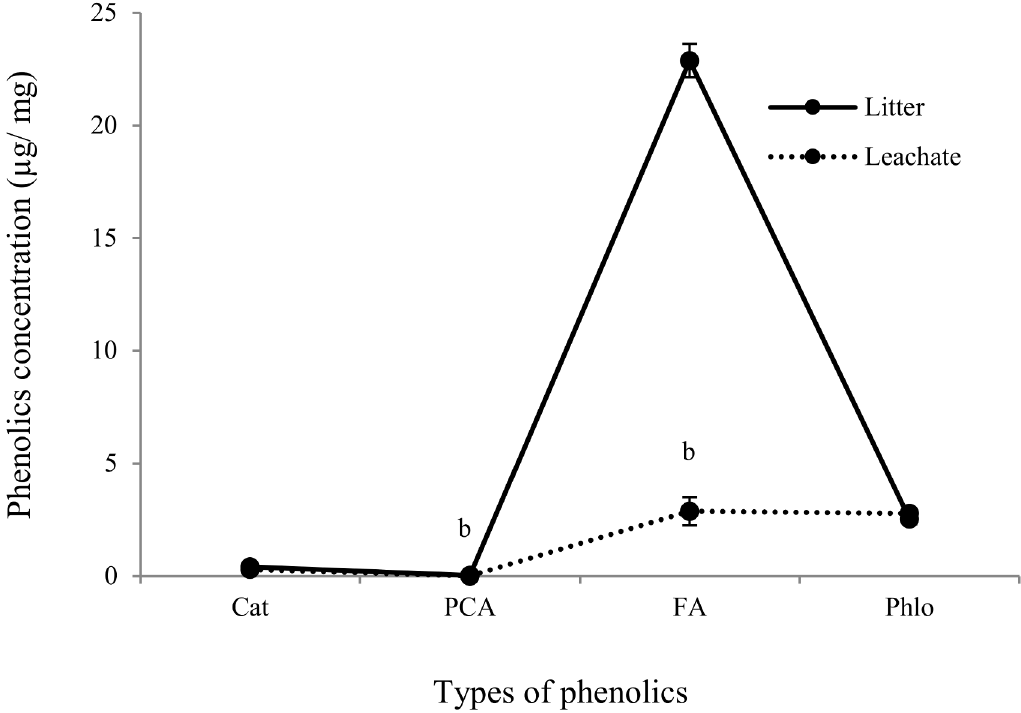
Fig 3. Concentrations of phenolic compounds in decomposed boneseed litter-mediated soil leachate. The x-axis denotes the types of phenolic compounds e.g., catechin (Cat), p-coumaric acid (PCA), ferulic acid (FA) and phloridzin (Phlo). Values on y-axis denote the concentration of phenolic compounds in boneseed organs in μ g/ mg. The solid line denotes the phenolics in non-decomposed litter leachate while dotted line represents in decomposed leachate. The error bar indicates the standard error. The letter b on top of markers depicts the significant decrease of phenolic compounds in decomposed leachate compared with non-decomposed leachate while blank means non-significant